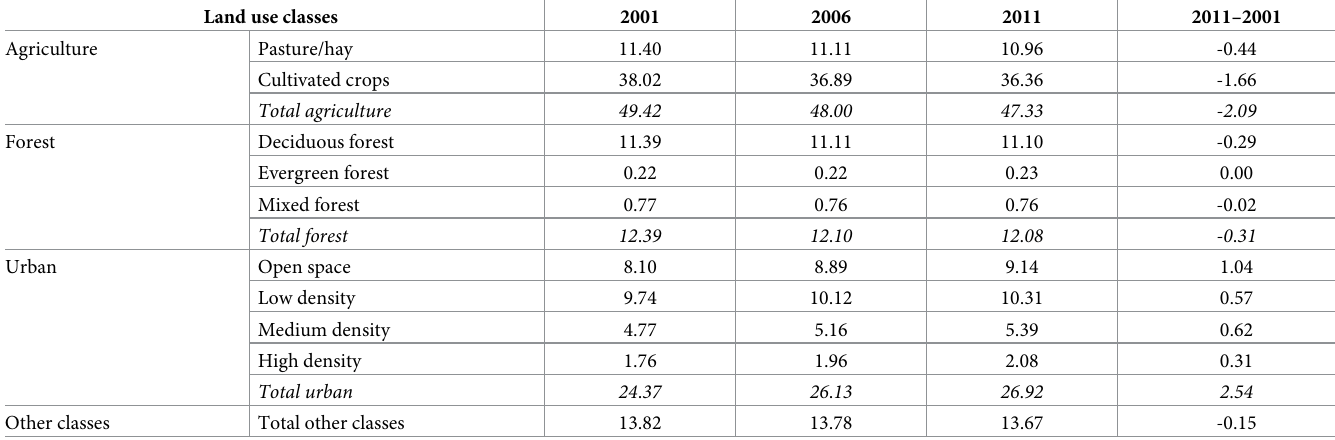
Table 1. Percent of land use classes of SEWI in 2001, 2006, and 2011 and change in percent coverage from 2001 to 2011. Land use